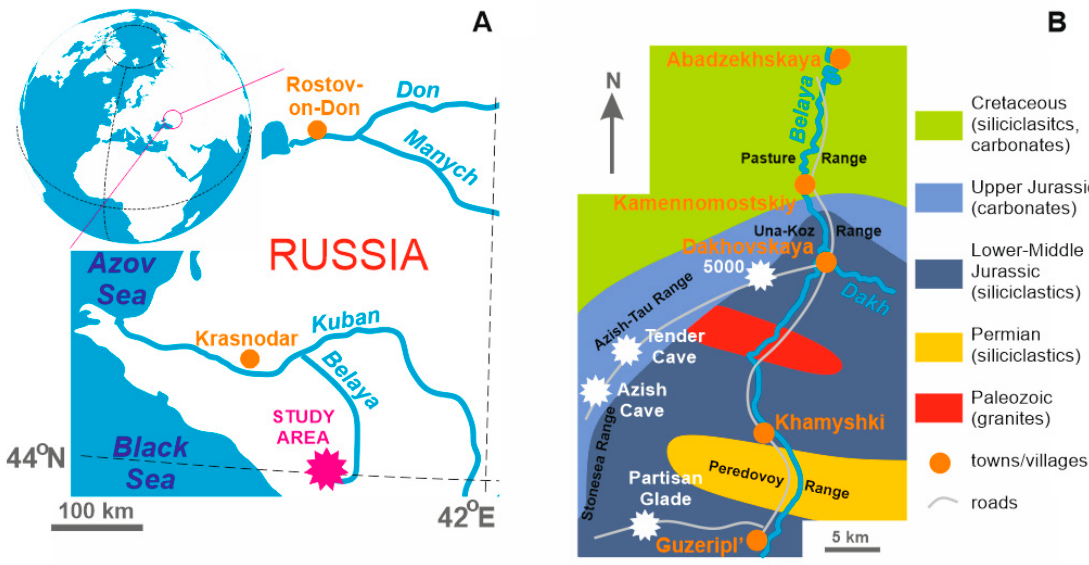
Figure 1. Geographical location of the study area ( A ) and the dispersed geoheritage points ( B ).